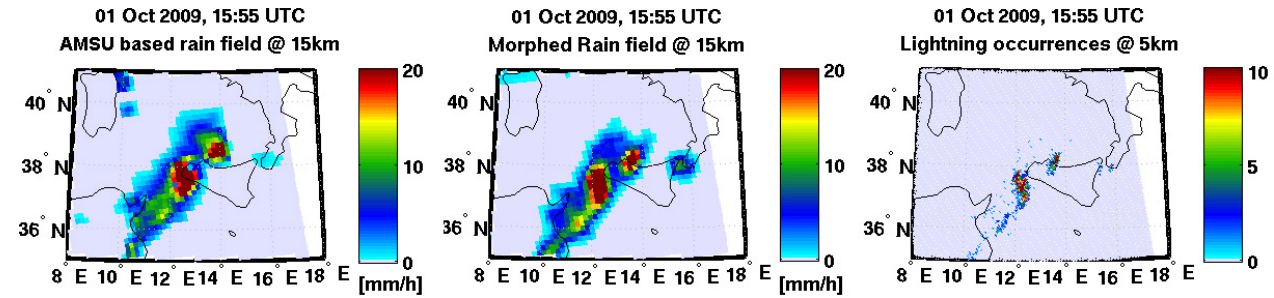
Fig. 7. Rain field provided by the AMSU-based algorithm applied to TB from NOAA 15 satellite compared with contemporary rain field provided by L-PET algorithm and lightning occurrences used for the algorithm, over southern Italy region, 1 October 2009 at 15:55UTC.